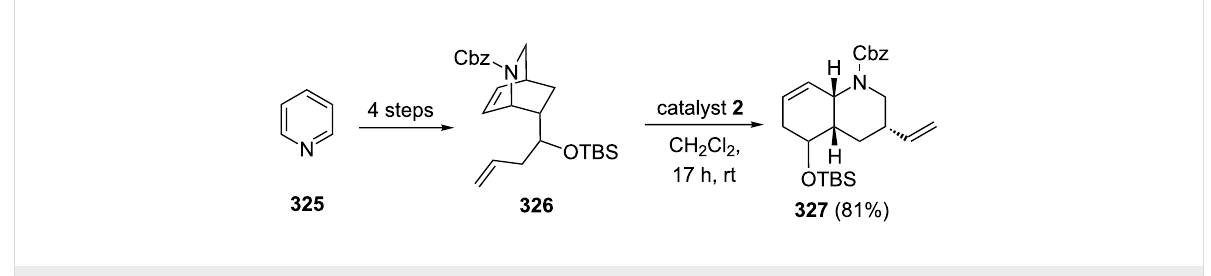
Scheme 71: RRM protocol to generate luciduline precursor 327 with catalyst 2 .